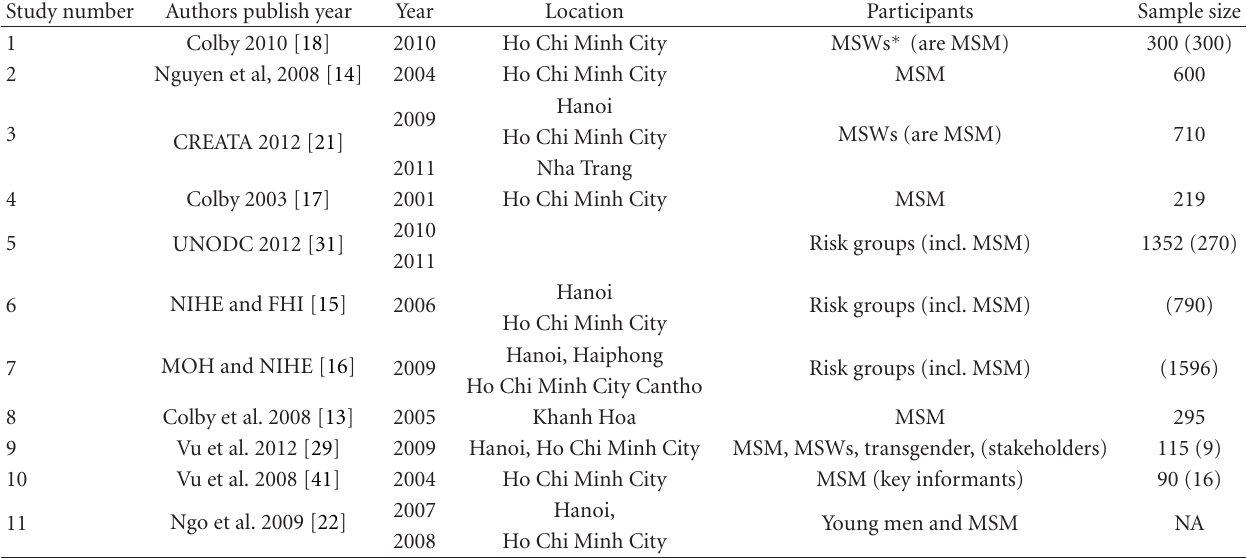
Table 1: Research studies on men who have sex with men (MSM) included in this